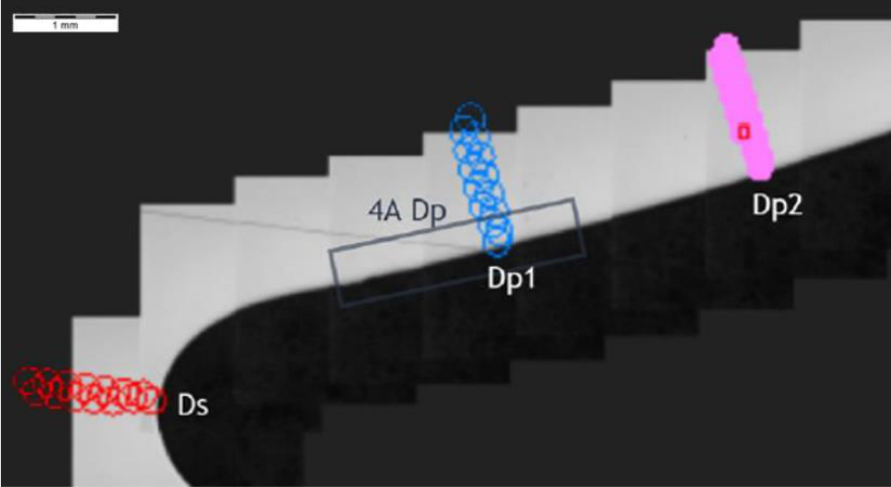
Figure 21. Pattern of hardness verification. Cross-section H-H.